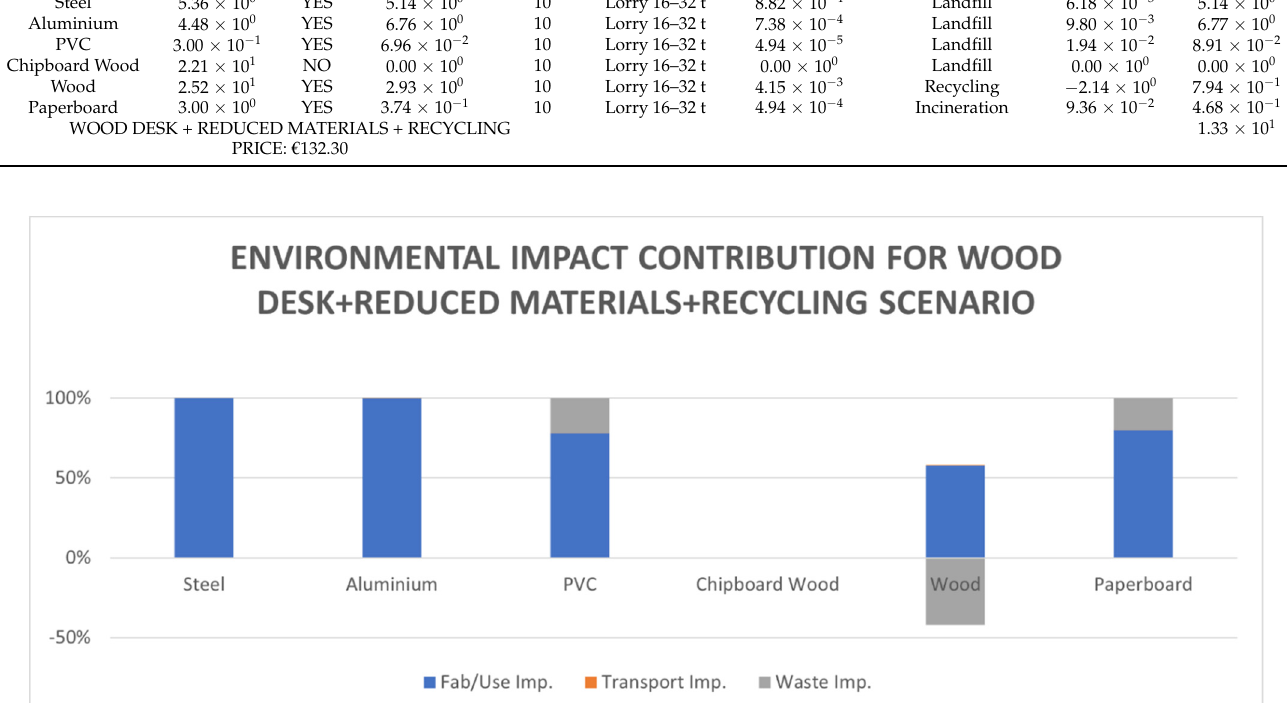
Figure 5. Environmental impact contribution for wood desk + reduced materials + recycling scenario.